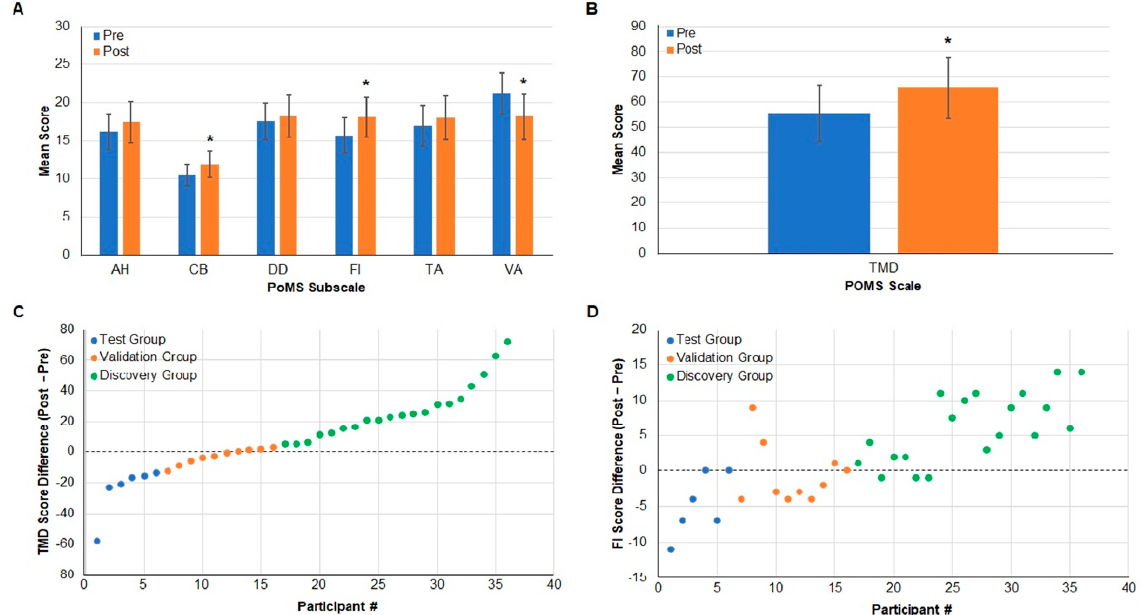
Figure 1. Difference in Total Mood Disturbance (TMD) as assessed by the Profile of Mood States (PoMS) allows separation into Discovery, Validation, and Test groups. ( A ) The PoMS scores for anger–hostility (AH), confusion–bewilderment (CB), depression–dejection (DD), fatigue–inertia (FI), tension–anxiety (TA), and vigor–activity (VA) are shown pre- and post-work shift. CB * p = 0.003, FI * p = 0.0393, and VA * p = 0.0047. ( B ) The combined TMD score for all participants’ pre- and post-work shifts is shown; * p = 0.0200. ( C ) The number of participants sorted into each group ( x -axis), and the difference between pre- and post-work shift TMD ( y -axis) is shown. The 6 participants with the greatest decrease in TMD score are in the Test group (blue), the 20 participants with the greatest increase in the Discovery group (green), and 10 intermediate participants in the Validation group (orange). ( D ) The number of participants sorted into each group ( x -axis), and the difference between pre- and post-work shift FI ( y -axis) is